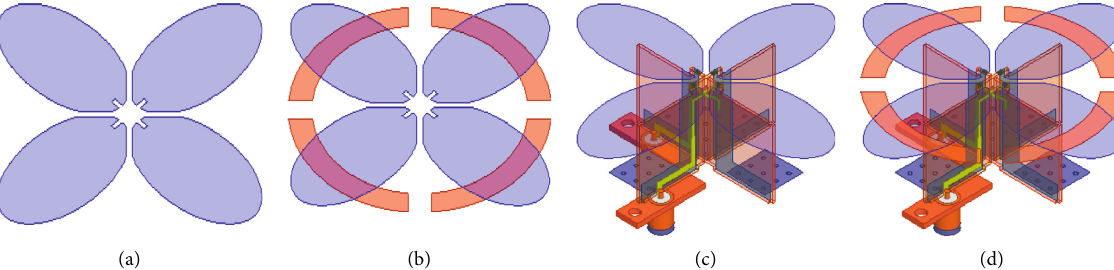
Figure 2: Evolution of the proposed antenna. (a) Ref. 1: patch + GND. (b) Ref. 2: patch + SR + GND. (c) Ref. 3: patch + balun + GND. (d) Proposed antenna: patch + SR + balun +